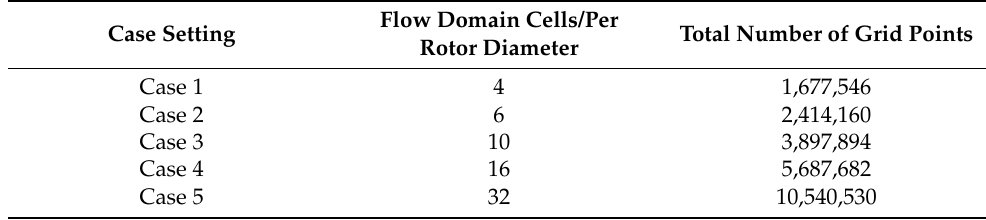
Figure 2. View of grids on the spanwise plane and view in the streamwise direction. Table 3. Grid refinement